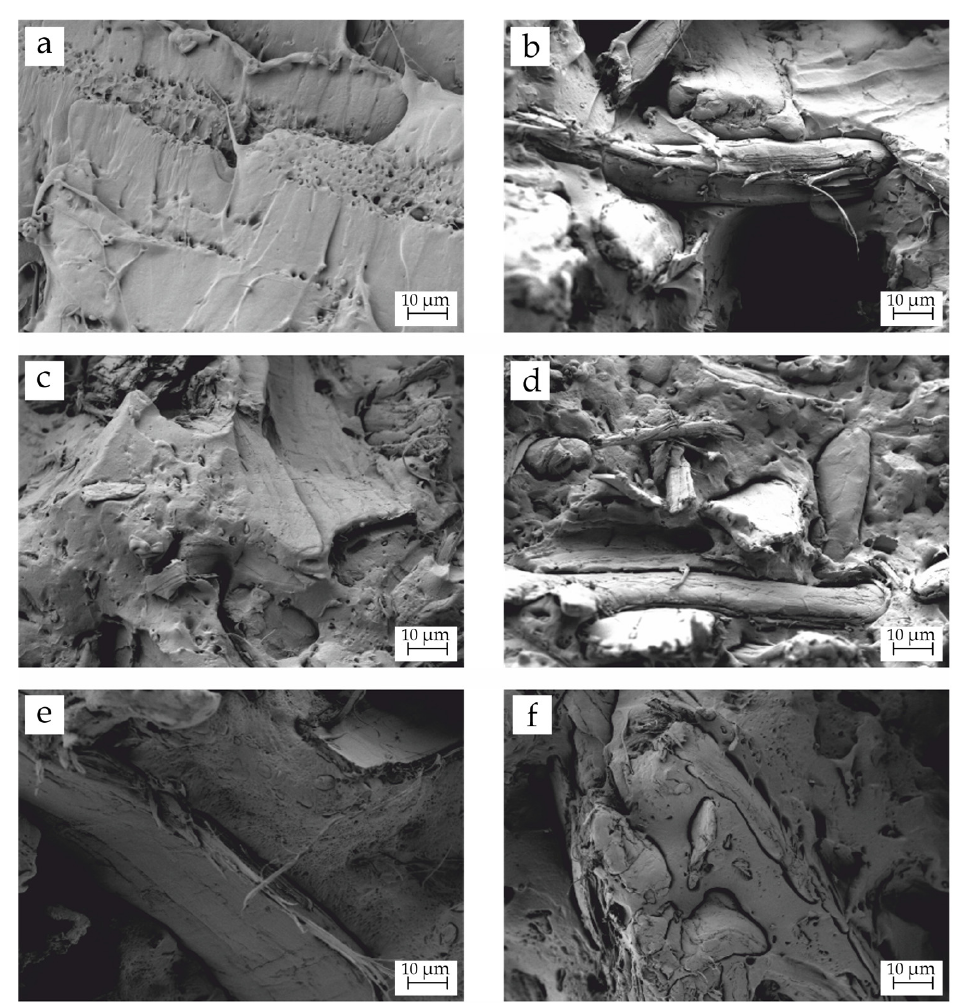
Figure 1. Field emission scanning electron microscopy (FESEM) images at 1000 × of the fractured surfaces of ( a ) neat BioPBSA; ( b ) BioPBSA/HEMP; ( c ) BioPBSA/HEMP/7.5DBI; ( d ) BioPBSA/HEMP/15DBI; ( e ) BioPBSA/HEMP/PBSA- g -IA; ( f ) BioPBSA/HEMP/PBSA- g -MA.